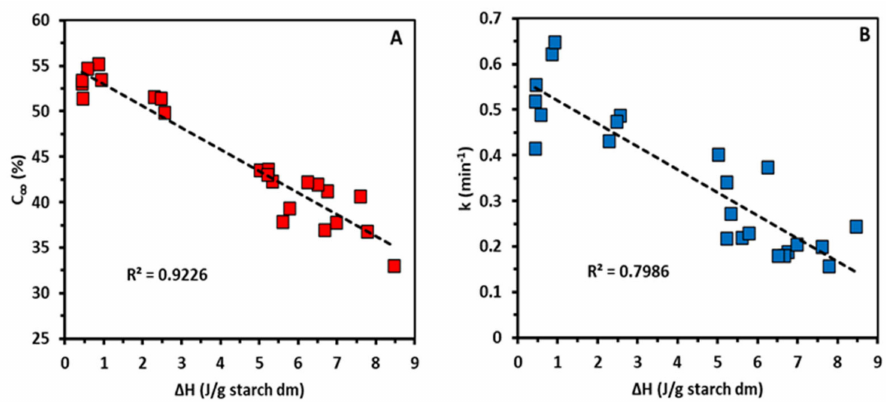
Figure 4. Relationship between the melting enthalpies ( ∆ H) of starches modified by different dosages of amylomaltase (AMM) (U/g starch dm) during rapid visco analysis (RVA) and subsequently stored at 5 ◦ C for 24 h and ( A ) the extent of starch digestion (C ∞ ) and ( B ) the starch digestion rate constant